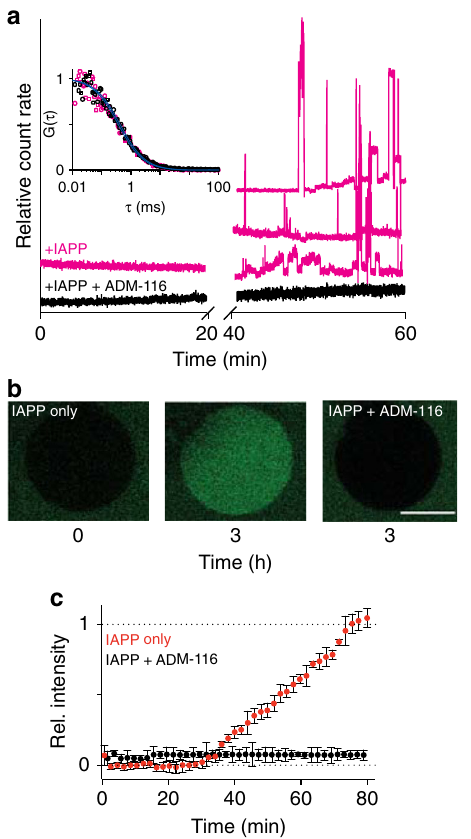
Fig. 2 Alternative sieve sizes resulting from IAPP oligomer mediated poration. a FCS of fl uorescent conjugates that have leaked out of 5 μ M lumen labelled GPMVs after application of 50 μ M IAPP. Representative traces of photon bursts are monitored over time in the absence (magenta) and presence of equimolar ADM-116 (black). Conditions are matched to those used in Fig. 1b and c. Inset: two representative autocorrelation analyses from the fi rst 20 min overlaid with fi ts (blue) to a single-diffusing species. Autocorrelations were similarly computed for traces taken from 40 to 60 min (Supplementary Fig. 3). b Confocal fl uorescence imaging of 500 nM GFP in the presence of 5 μ M unlabelled GPMVs. Leakage was initiated by applying 50 μ M IAPP. Conditions are matched to Fig. 1b, c. A representative 0 and 3 h time point of the same GPMV is shown. On right is a representative 3 h time point in which 50 μ M ADM-116 was also present. c Quantitation of kinetics of data as in b using summed intensities of GFP across the equatorial plane of GPMVs. Con fi dence intervals are standard deviations taken from a minimum of nine repeats. Scale bar for all images